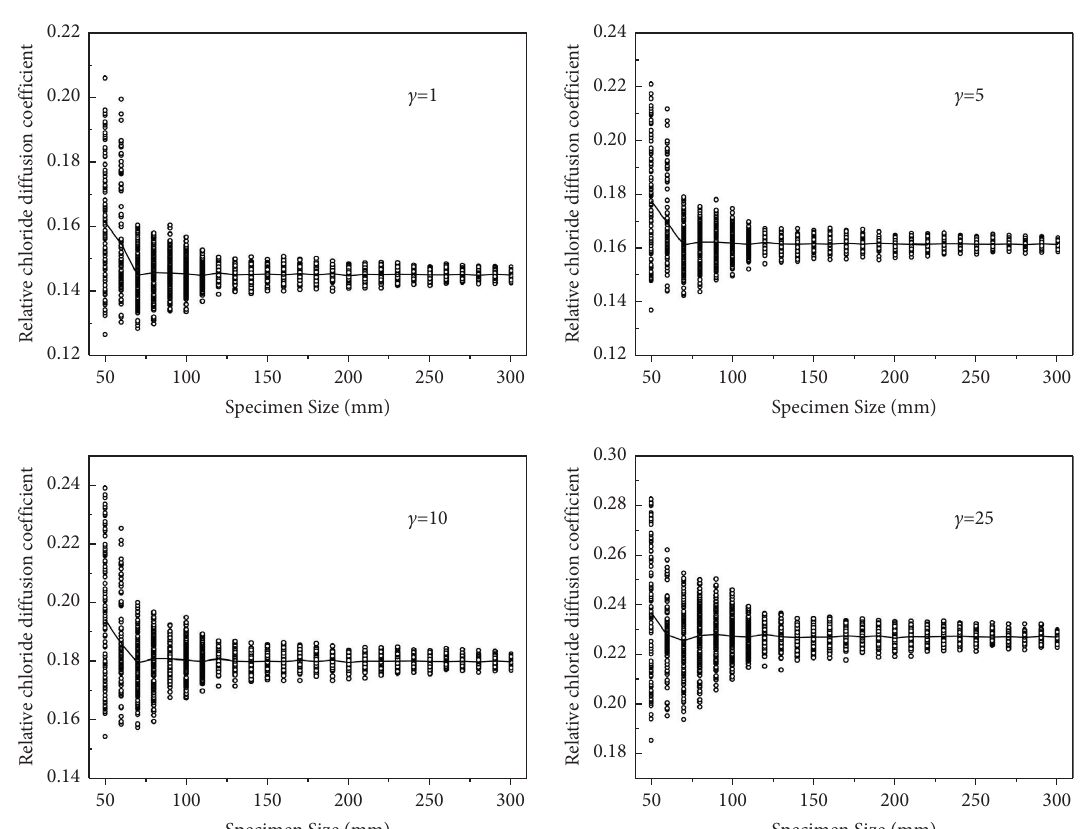
Figure 7: Relative chloride’s difusion coefcients in concrete at diferent sizes ( k � 0 .